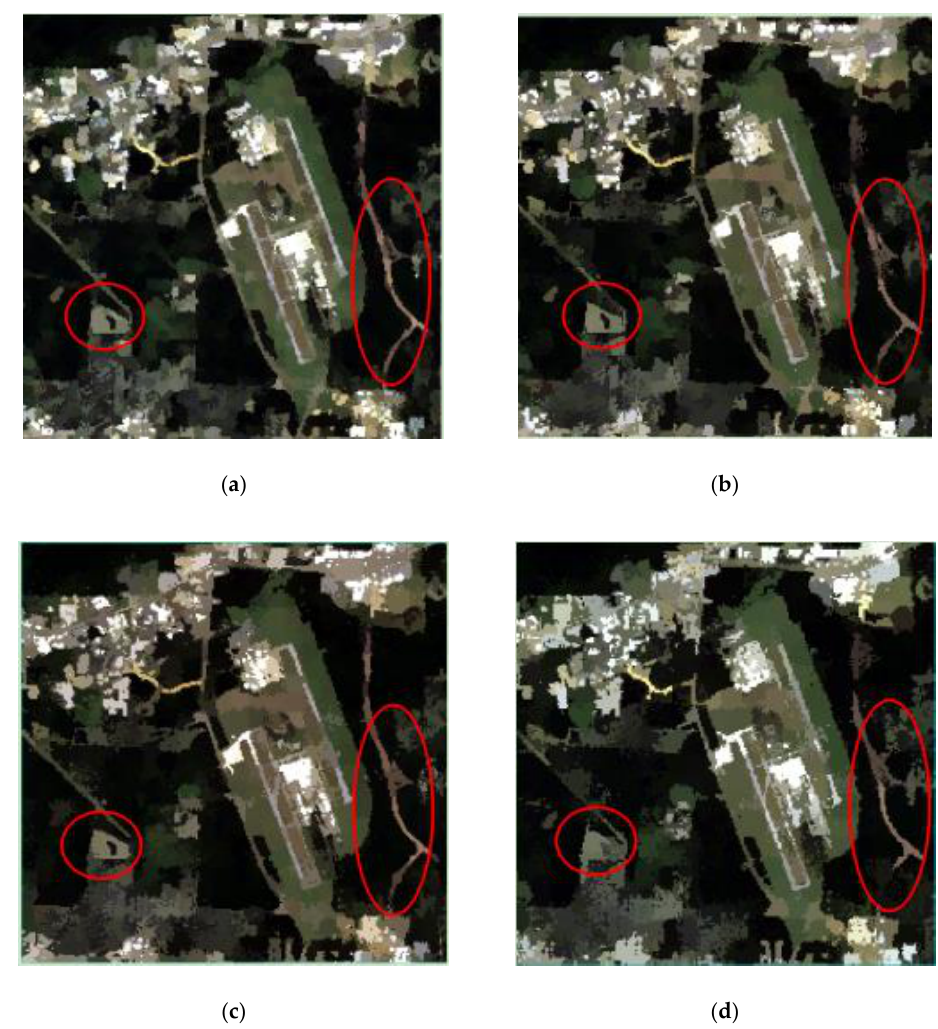
Figure 10. Results of different segmentation steps for Landsat satellite imagery: ( a ) S = 5; ( b ) S = 7; ( c ) S = 9; ( d ) S = 11.